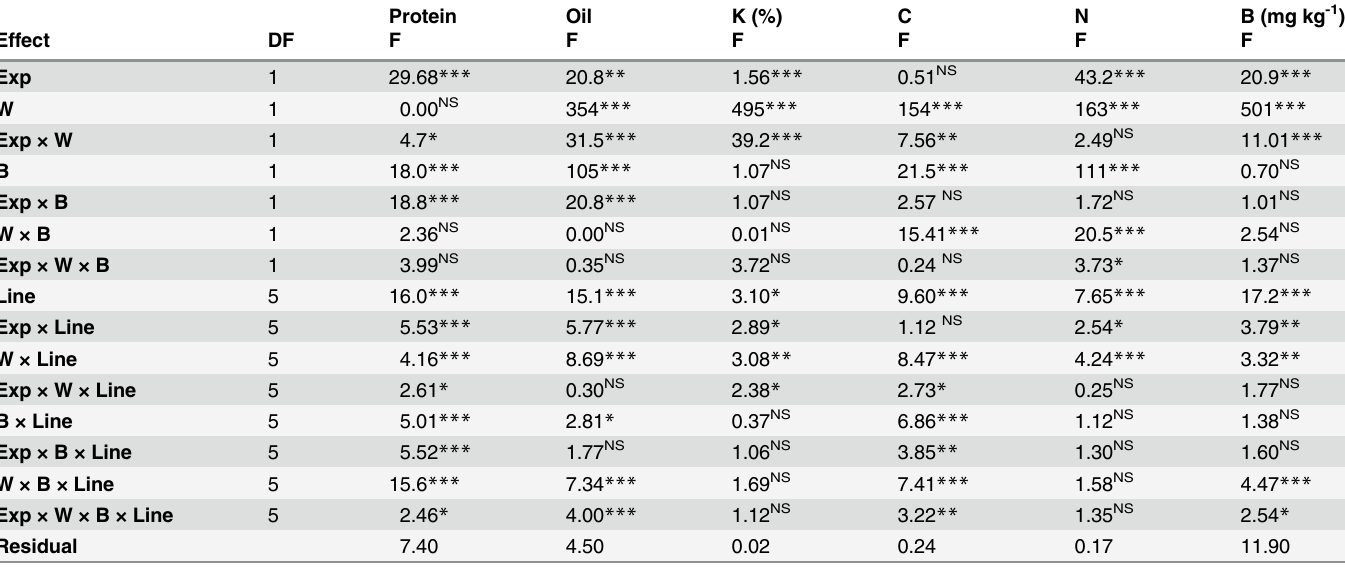
Table 1. Effect of source of variance (F value and P significant level) on cottonseed protein, oil, K, C, N, and B in near-isogenic lines (Line) express- ing fuzzy and fuzzless seed phenotypes under water stress (well-watered and water stressed plants; W) with and without foliar B application (B) in a repeated (Experiment 1 and Experiment 2; Exp) greenhouse